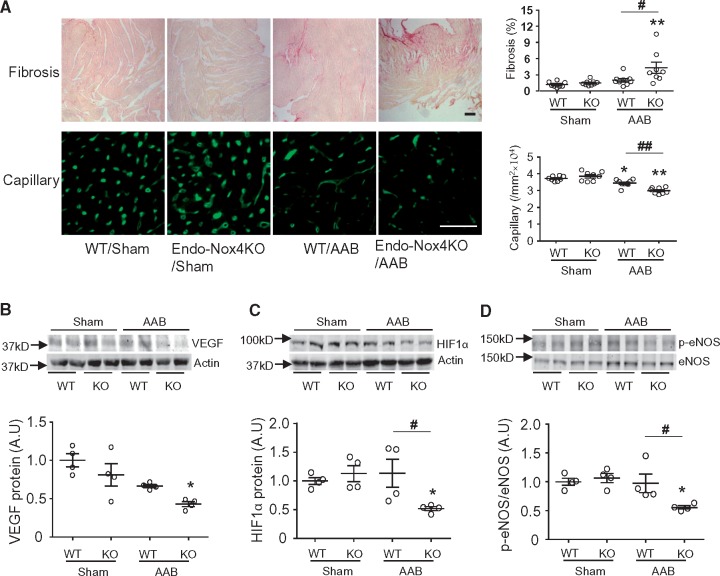
Myocardial interstitial fibrosis and capillary density in Endo-Nox4KO mice. (A) Representative LV sections from Endo-Nox4KO mice and WT littermates stained for myocardial fibrosis and capillaries; scale bars 50 μm. Mean data are shown on the right (n = 8–9/group). (B–D) Protein levels of VEGF-A, HIF1α, p-eNOS, and total eNOS in LV of Endo-Nox4KO mice compared to respective WT. Representative immunoblots are shown at the top and mean data below (n = 4/group). *P < 0.05, **P < 0.01 vs. respective sham controls. #P < 0.05, ##P < 0.01 vs. WT/AAB, two-way ANOVA with Tukey’s Multiple Comparison Test. All data are presented as mean ± SEM.